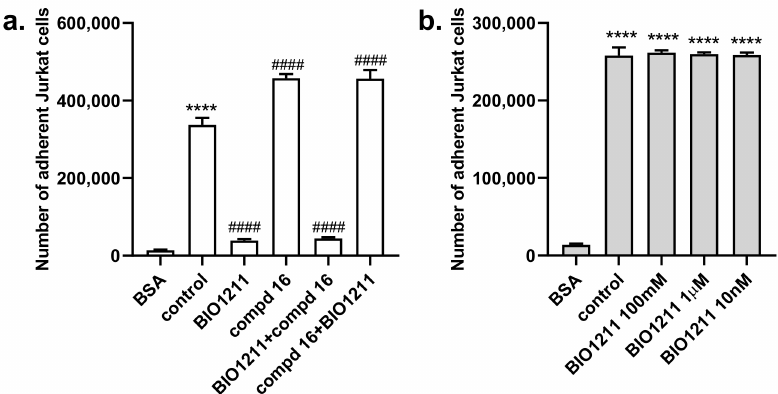
Figure 8. Jurkat cell adhesion to wells coated with VCAM-1 [2 µ g/mL; panel ( a )] or compound 16 [10 µ g/mL; panel ( b )] to evaluate any possible ligand binding competition. ( a ) . The antagonist BIO1211 (1 µ M) significantly reduced Jurkat cell adhesion to VCAM-1; on the contrary compound 16 (100 µ M) behaved as an α 4 β 1 integrin agonist, increasing the adhesion of Jurkat cells to VCAM-1. When Jurkat cells were pre-incubated with BIO1211 and then with compound 16 , the latter was not able to modify the reduction in adhesion induced by BIO1211. Similarly, BIO1211 was not able to revert the effect induced by pre-incubation with compound 16 . ( b ). Even in absence of VCAM-1, compound 16 was able to induce Jurkat cell adhesion; BIO1211 (10 nM–100 mM) was not able to reduce the increment of cell adhesion induced by compound 16 . Control cells were not pre-incubated with any compound. Jurkat cells plated in wells coated with 10 µ g/mL bovine serum albumin (BSA) were considered as negative control. Each value is the mean ± SD from four separate experiments carried out in quadruplicate. **** p < 0.0001 vs. BSA-coated wells; #### p < 0.0001 vs. control (Newman–Keuls test after